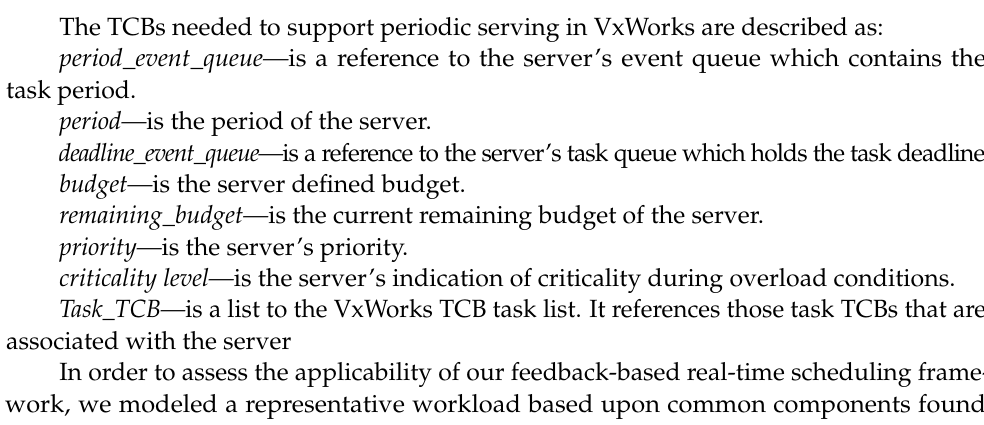
Figure 8. Implementation for periodic